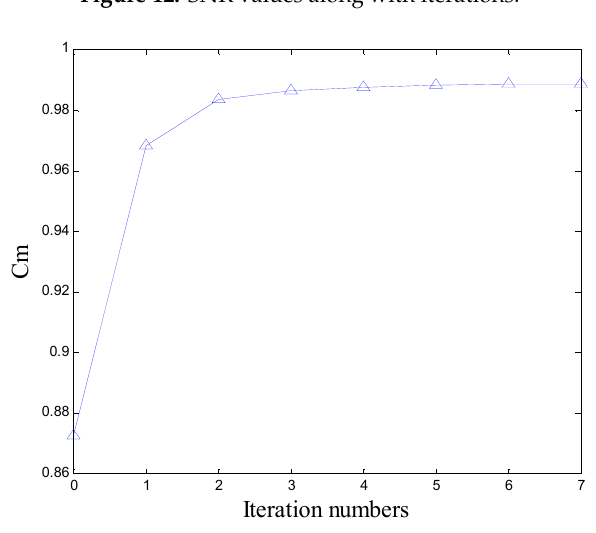
Figure 13. Cm values along with iterations.